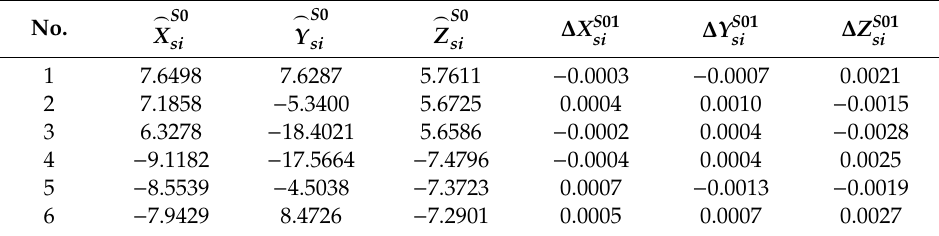
Table 4. Optimization data and correction data of common points of the 3D scanner (unit: mm).